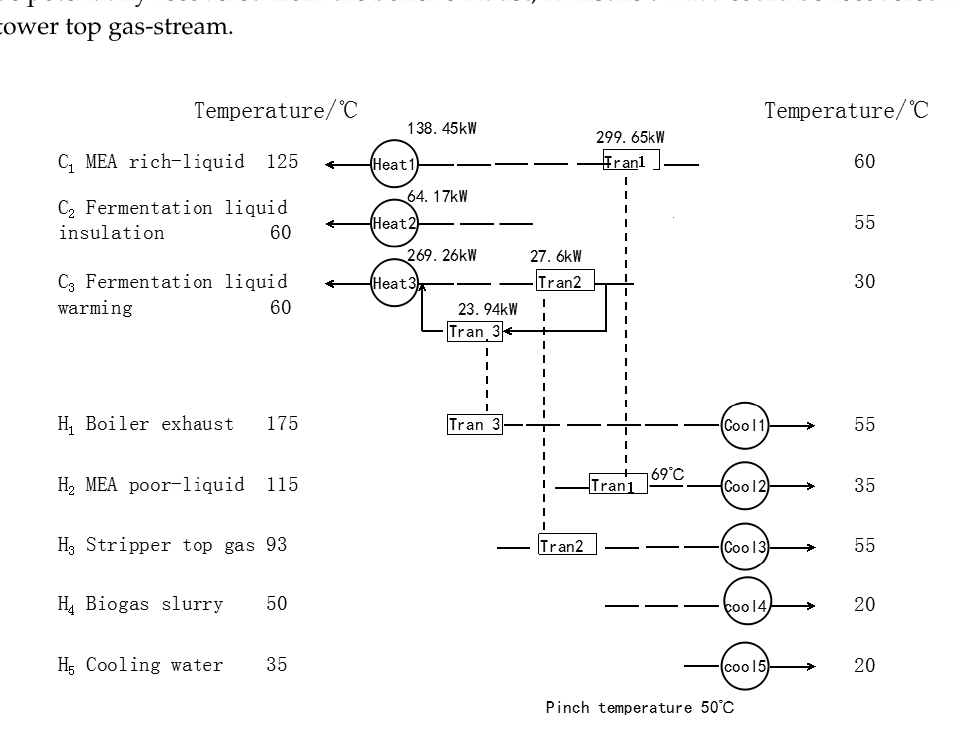
Figure 8. Heat exchanger network after retrofitting.